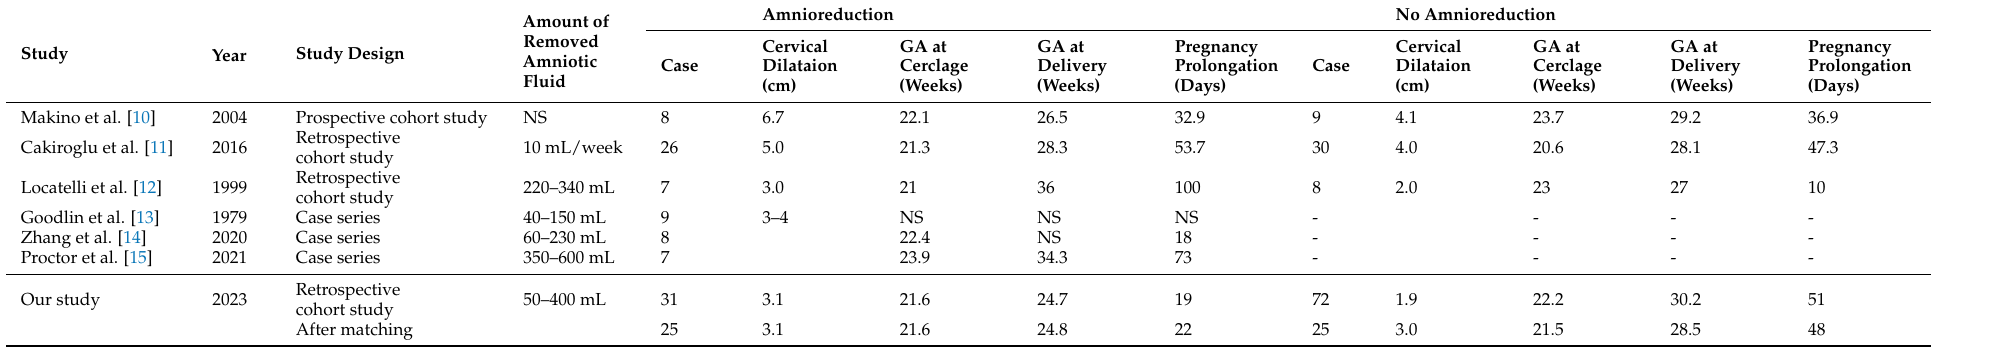
Table 4. Existing studies on amnioreduction before physical examination-indicated cerclage excluding case